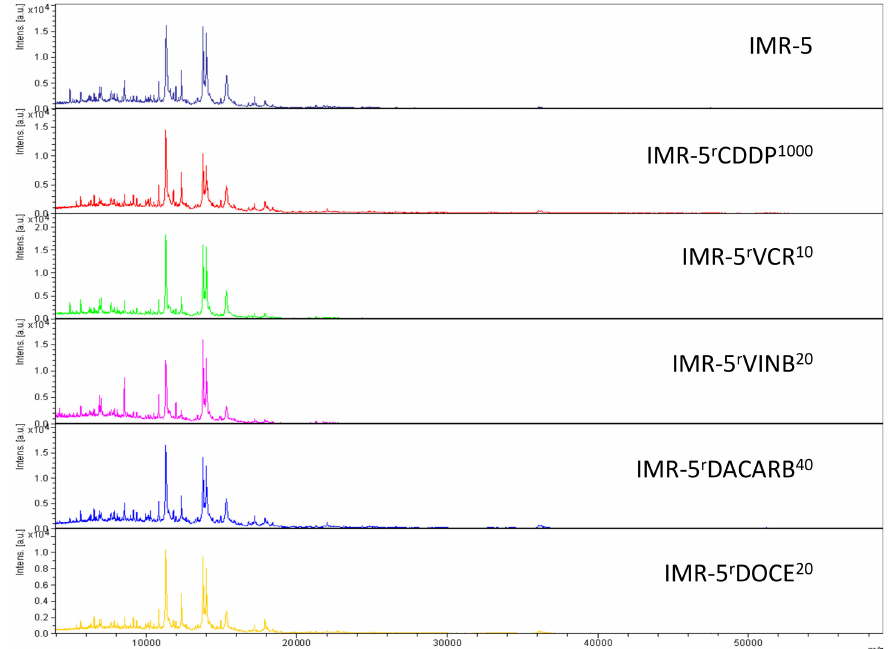
Figure 3. Representative intact-cell MALDI-ToF mass spectrometry analysis spectra of the cell line IMR-5 and its drug-adapted sublines.